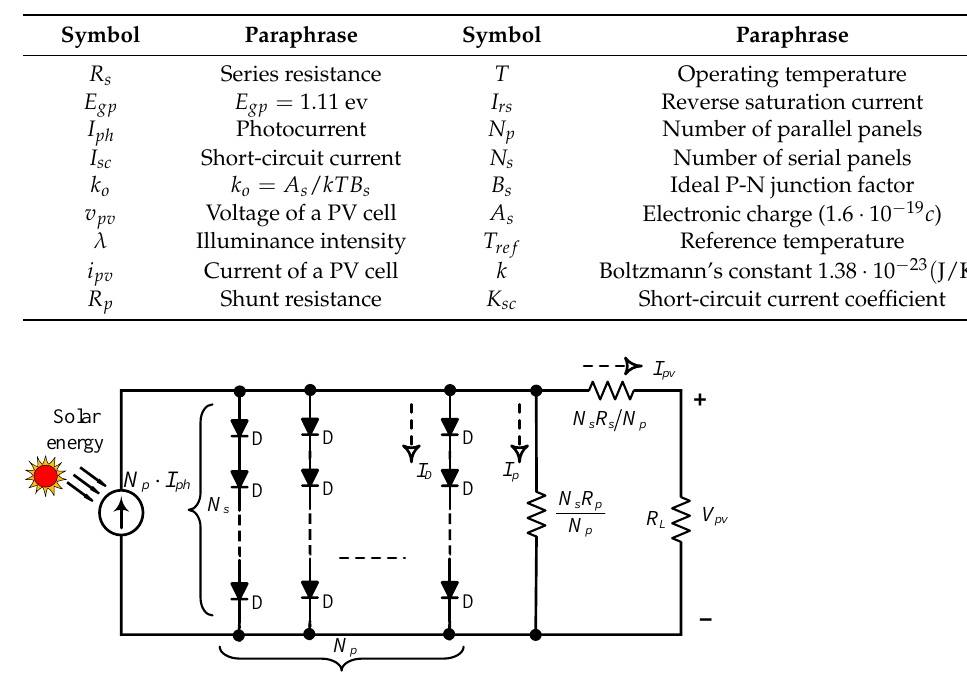
Table 1. Symbols and paraphrase for the PV panel.